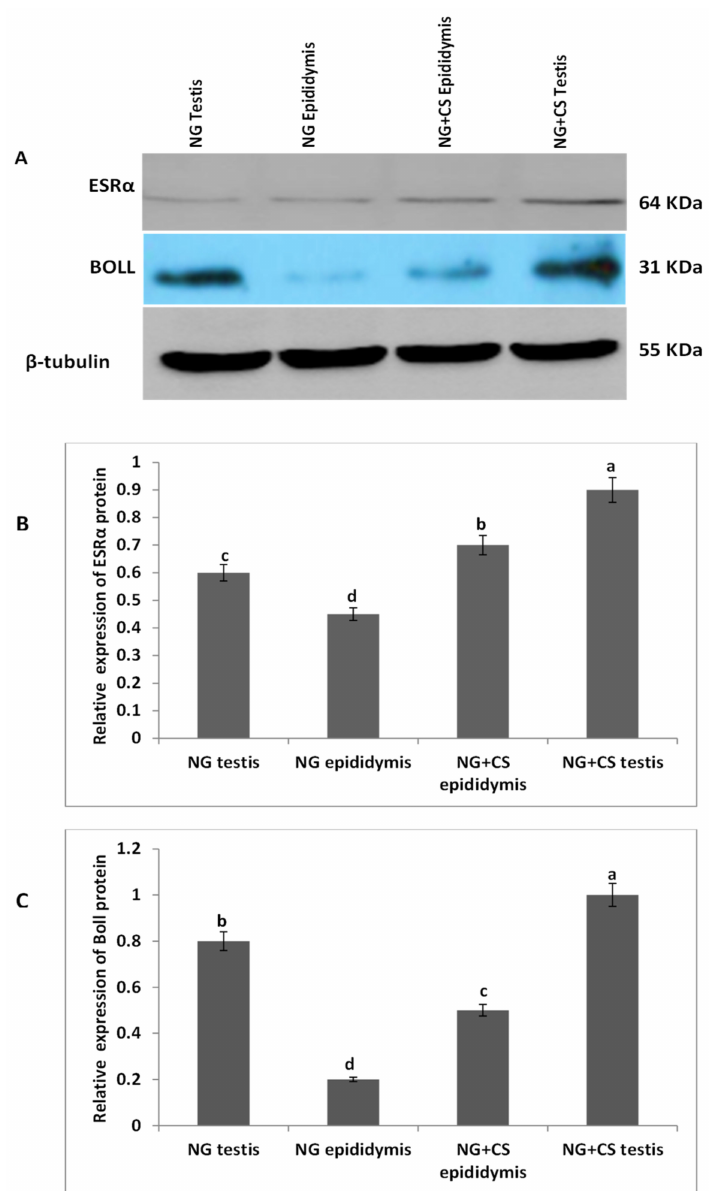
Figure 2. Characterization of ESR α and BOLL proteins in the testes and epididymis of Datong yaks with and without concentrate supplementation: ( A ) Western blotting of ESR α and BOLL proteins; and the full Western blotting of ESR α and BOLL proteins is shown in Figure S1; ( B ) relative ex- pression of ESR α protein; ( C ) relative expression of BOLL protein; (1) testis without concentrate supplementation; (2) epididymis without concentrate supplementation; (3) epididymis with con- centrate supplementation; (4) testis with concentrate supplementation; Beta tubulin was used as control. Protein levels were quantified using densitometric analysis. Significant variations are shown by different letters ( p <